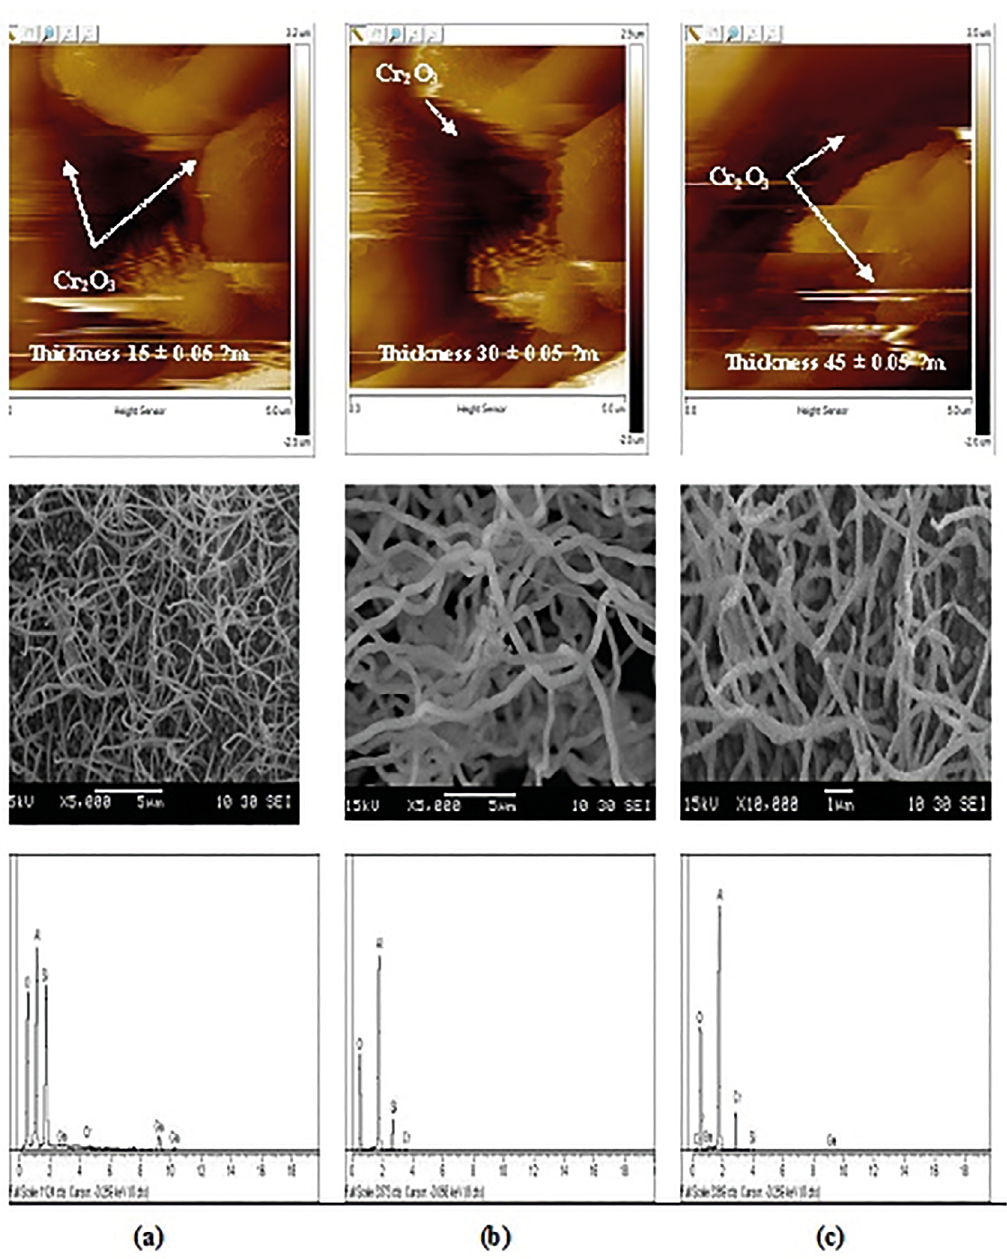
Figure 2. SEM of coating at thickness for (a) 15 ± 0.05 µm (b) 30 ± 0.05 µm and (c) 45 ± 0.05 µm after 60 min and 200 rpm